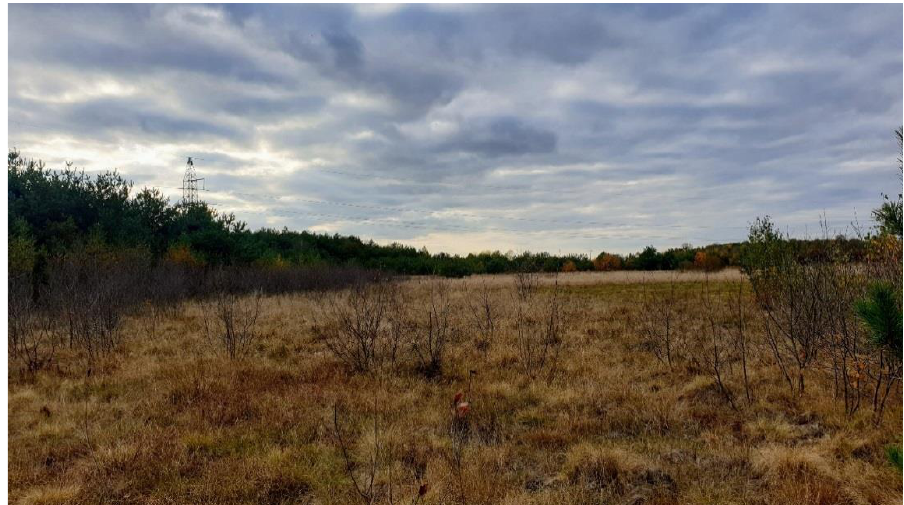
Figure 4. Site of tick collection, plot 17.